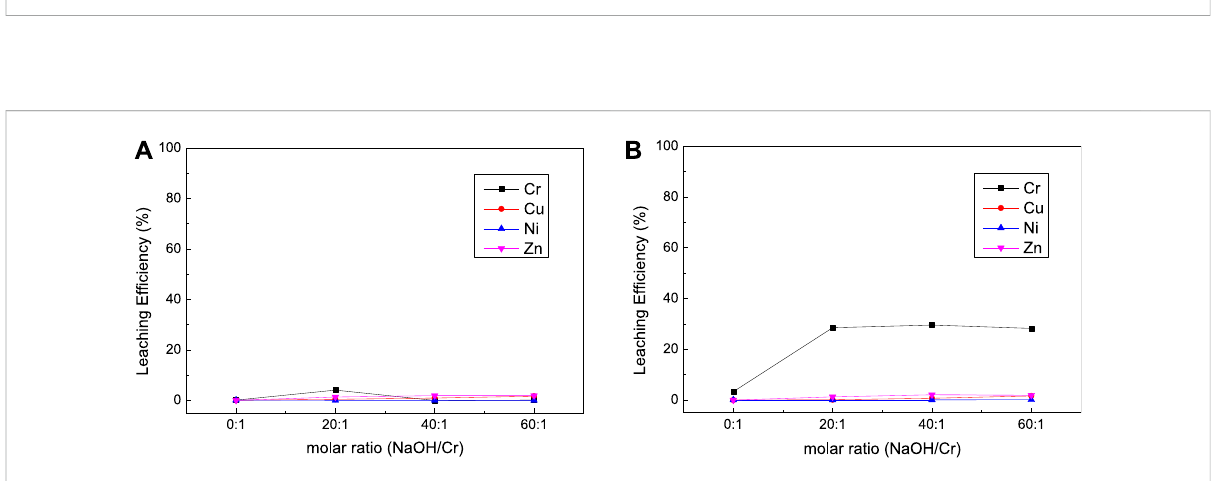
FIGURE 8 Effect of NaOH dosage on the leaching results [ (A) with H 2 O 2 ; (B) with NaClO] for complex sludge